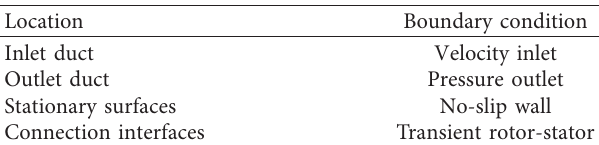
Table 1: Boundary conditions adopted in the numerical